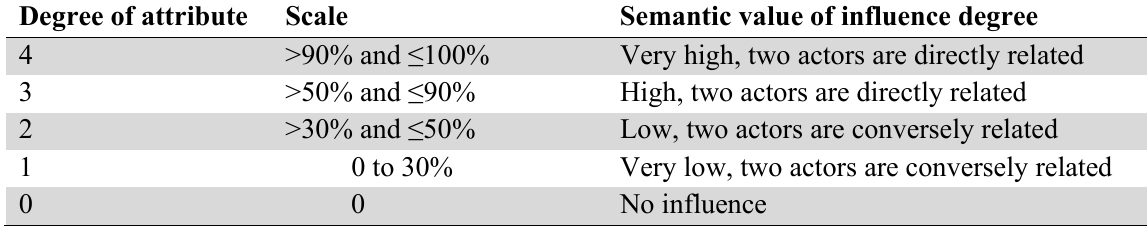
Likert scale for the technological risk criterion. Degree of attribute Semantic value of influence